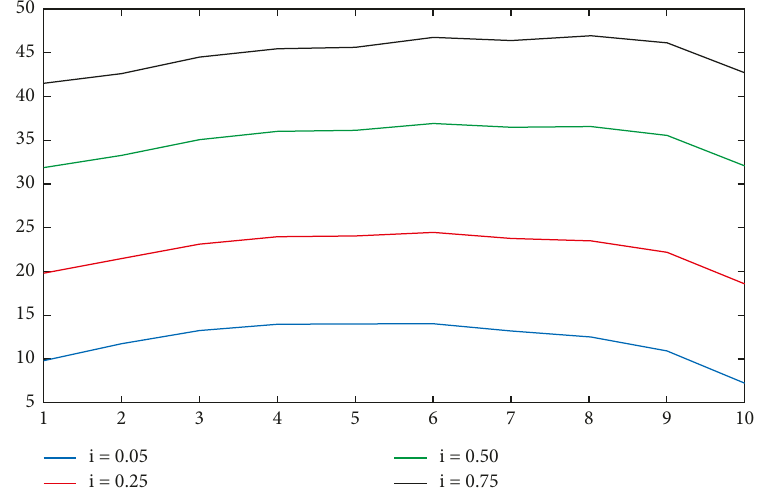
Figure 6: Wealth evolution by varying interest rate.